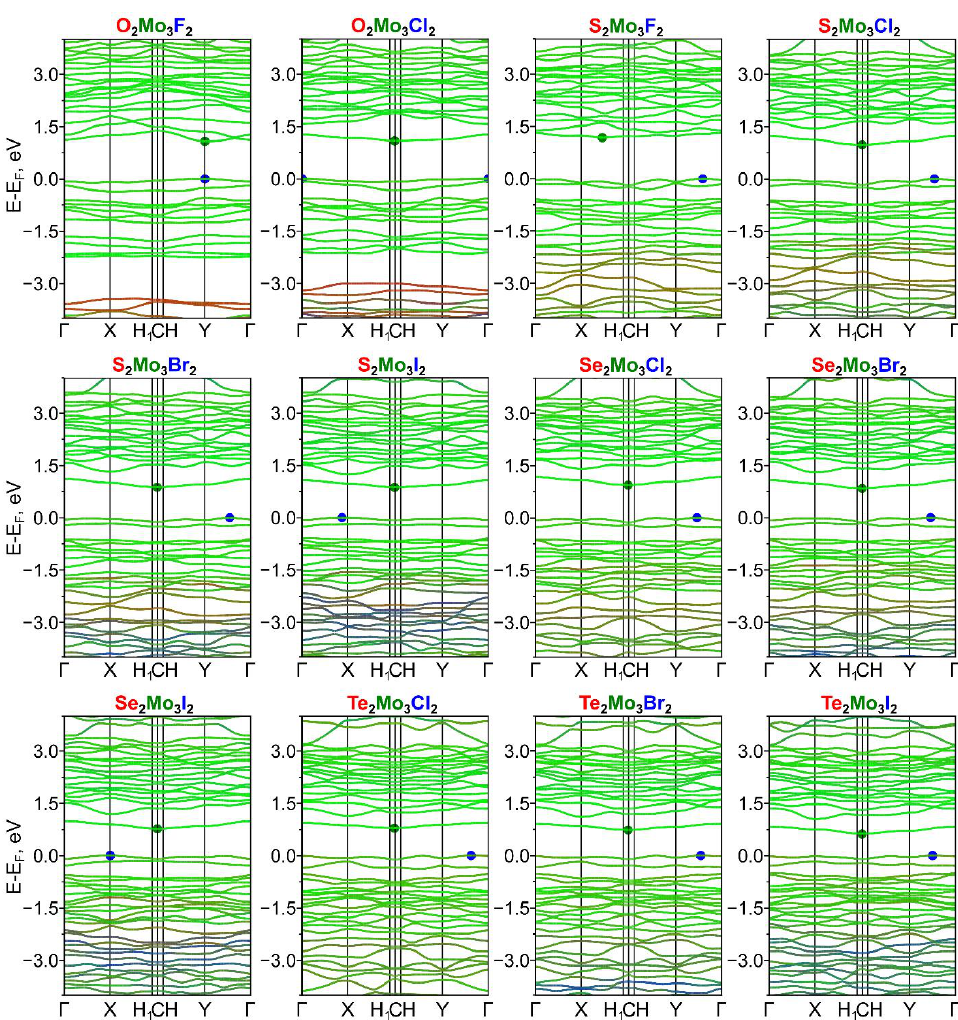
Figure 5. Atom-resolved electronic band structure of dynamically stable Janus Ch 2 Mo 3 Hal 2 (Ch = O, S, Se, Te and Hal = F, Cl, Br, I) Chevrel phases. The contributions from Ch, Hal , and Mo atoms are indicated with red, blue, and green colors, respectively.